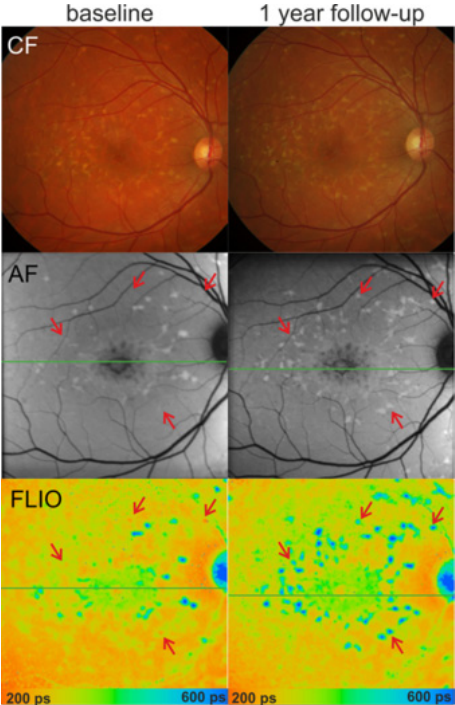
Fig. 8. STGD progression within one year. Color fundus (CFs), fundus AF, and FLIO (long spectral channel) with in- dicated lines of the optical coherence tomography scan (OCT) (baseline, left) A one year follow-up examination (right) shows clear disease progression with accumulation of hyper°uorescent °ecks. The red arrows mark areas with short °uorescence life- times that converted to long lifetimes within one year. 37 (Per- mission has been granted by \The Association for Research in Vision and Ophthalmology" through Creative Commons At- tribution, http://creativecommons.org/licenses/by-nc-nd/4.0.)